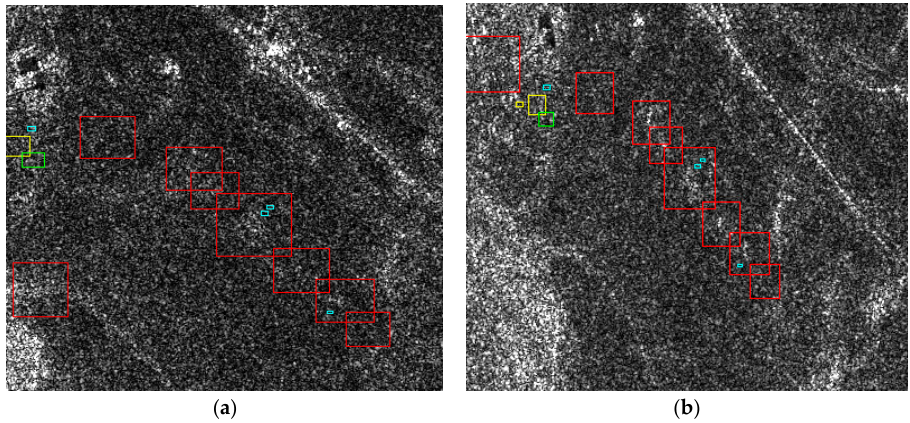
Figure 6. Cluster of Saka kurgans in TSX SL images acquired on 9 July 2015 ( a ) and 15 July 2015 ( b ); (SAR images © DLR, 2015). ( Saka kurgans = red, Scythian kurgans = green, ogradkas = purple, undatable mounds = yellow, and all other objects = cyan).